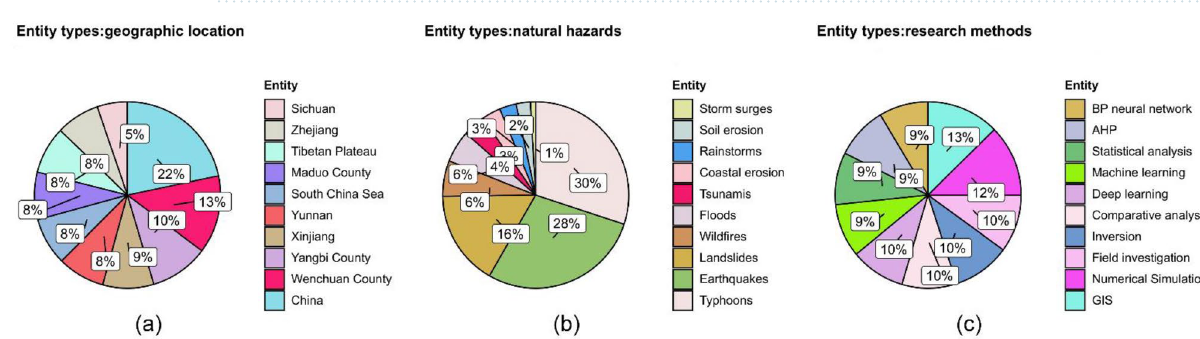
Figure 6. Statistics of natural hazard named entities: ( a ) shows the top 10 geographical location entities among the recognition results, ( b ) shows the top 10 natural hazards entities among the recognition results, ( c ) shows the top 10 research methods entities among the recognition results.